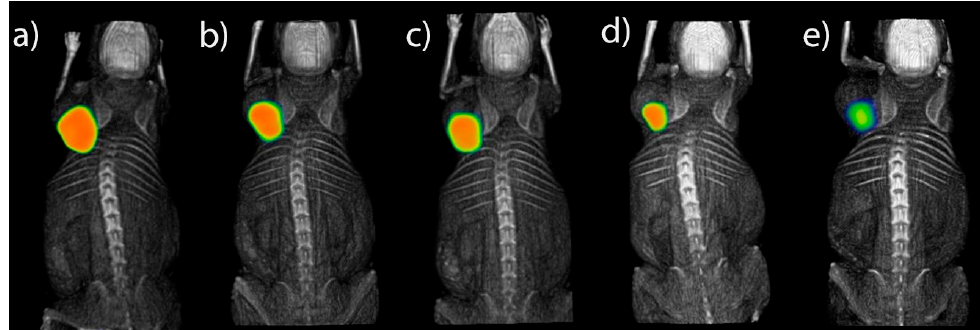
Figure 8. Subcutaneous tumoral model. Intratumoral administration of 177 Lu-DOTA-DN(PTX)-BN after ( a ) 1.5 h, ( b ) 9 h, ( c ) 10 h, ( d ) 24 h, ( e ) 120 h. Table 2. Biokinetic model and radiation absorbed dose produced by MBq of 177 Lu-BN-PLGA(PTX) to the T47D tumor (intratumoral administration).